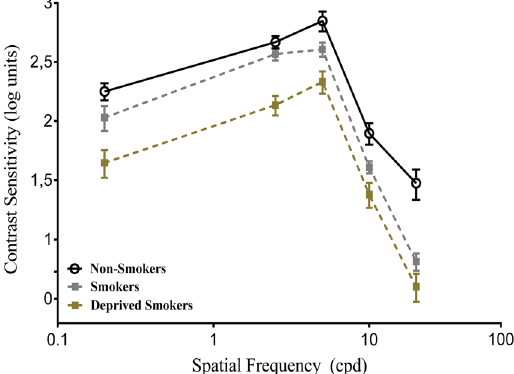
Figure 1. Contrast sensitivity curves as a function of spatial frequency (cpd) for non-smokers, smokers and deprived smokers. Each data point represents the sensitivity (reciprocal of contrast threshold) and error bars represents the standard deviation (SD) of the median sensitivity based on 1000 bootstrap resamplings. CSF is plotted in logarithmic